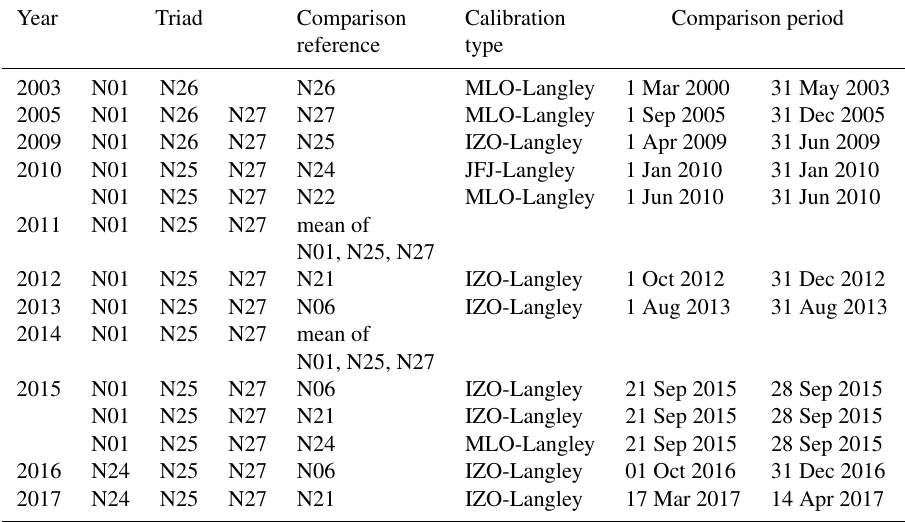
Table 1. Details of PFR triad Langley calibration measurements. Triad